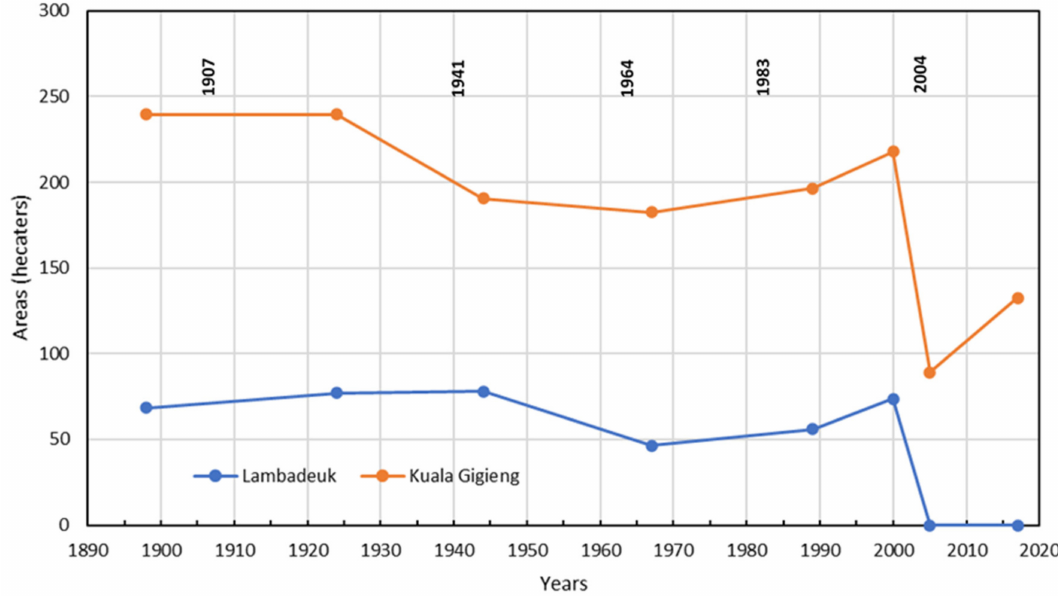
Figure 8. Historical land area trends for the Lambadeuk and Kuala Gigieng barrier islands to the timing of major earthquakes that impacted the